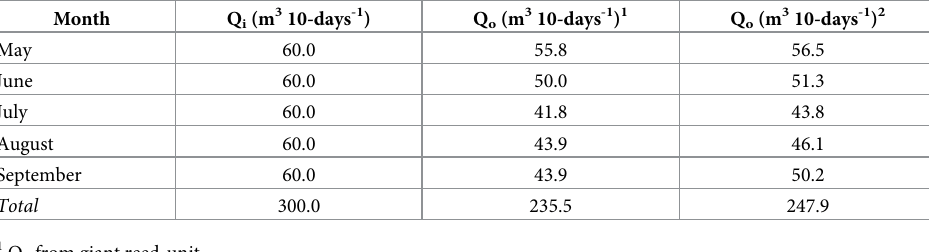
Table 4. Wastewater inflow and outflow rates in the HSSFs CW during summer. Average values of 3-year tests are shown.